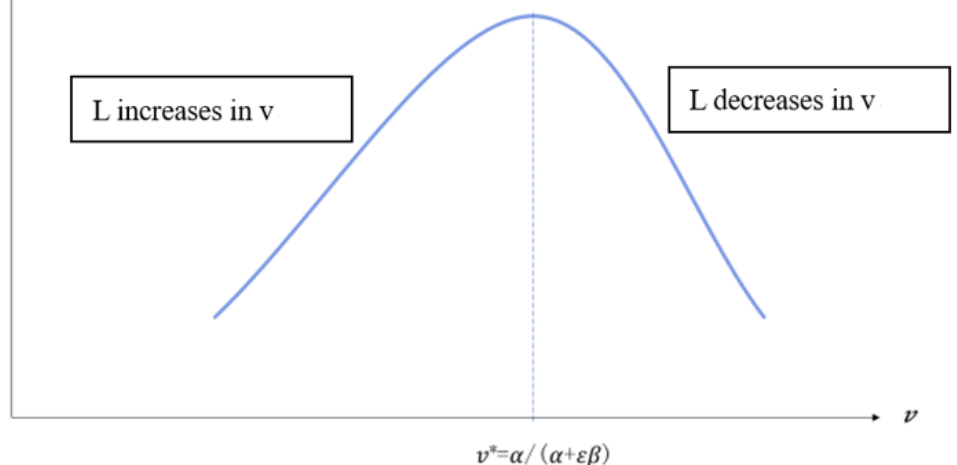
Figure 3. The transportation infrastructure and population flow. Note: v is the proportion of public expenditure on transportation and L is the number of labors in second